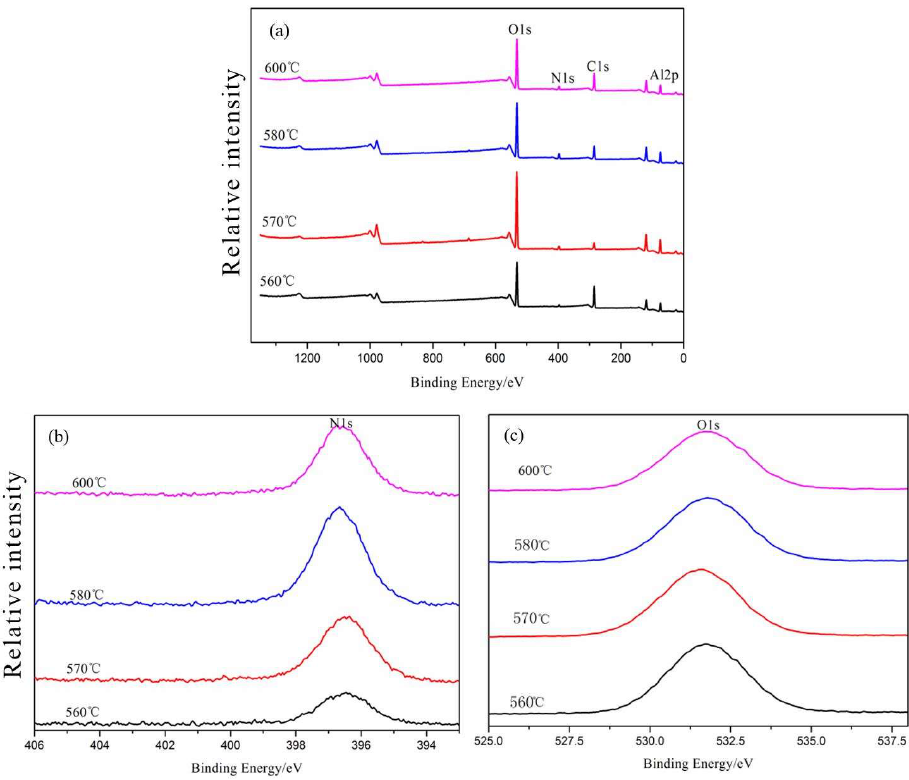
Figure 4. ( a ) X-ray photoelectron spectroscopy (XPS) of the ANs after surface nitridation, and higher